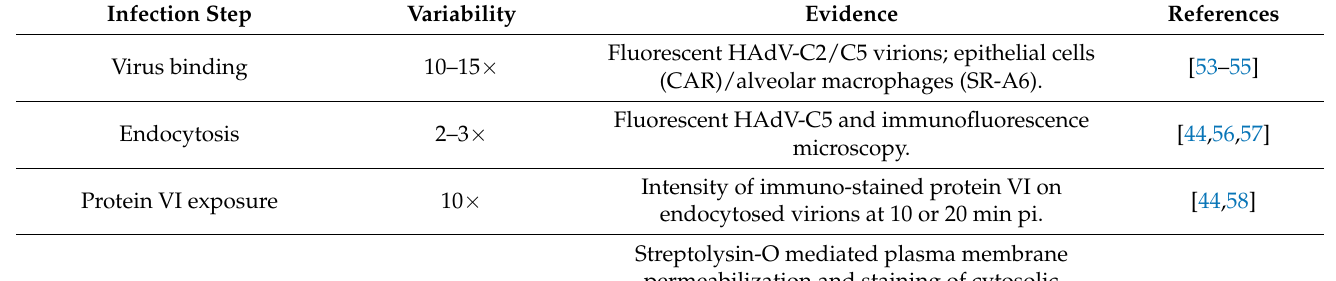
Table 1. Single entity assays reveal cell-to-cell variability in HAdV-C